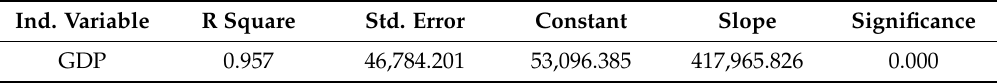
Table 2. Summary of the model with GDP as the variable.